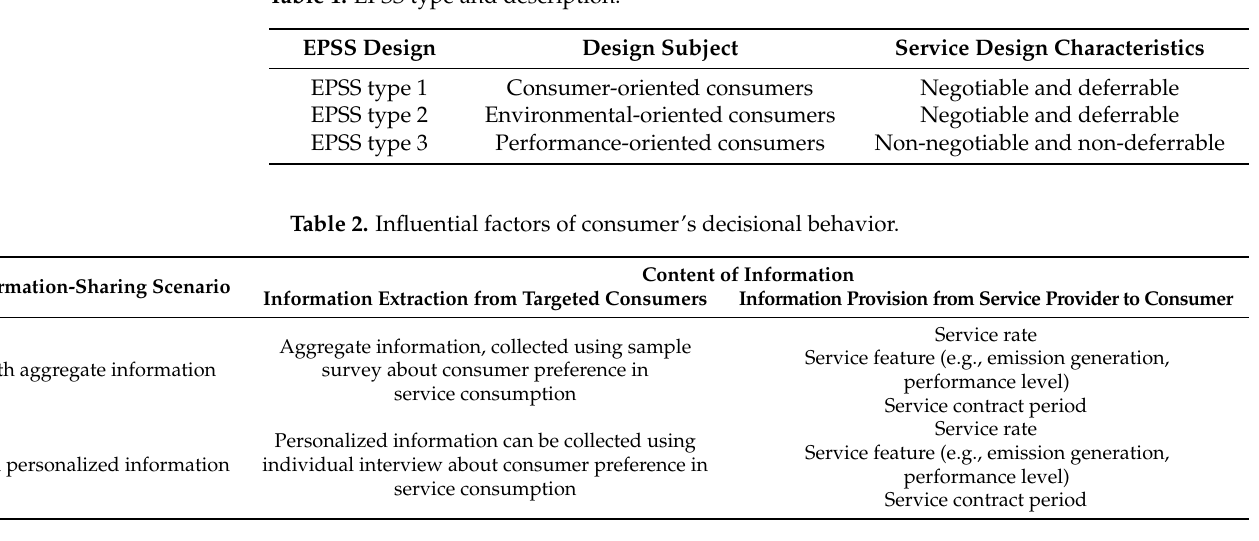
Table 1. EPSS type and description.